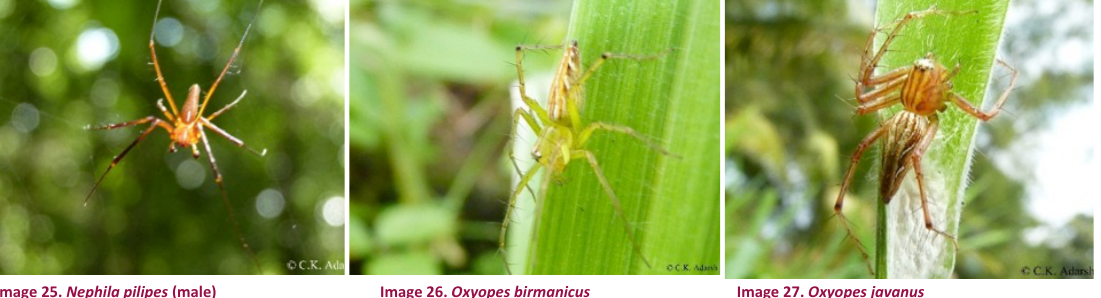
Image 25. Nephila pilipes (male) Image 26. Oxyopes birmanicus Image 27. Oxyopes javanus